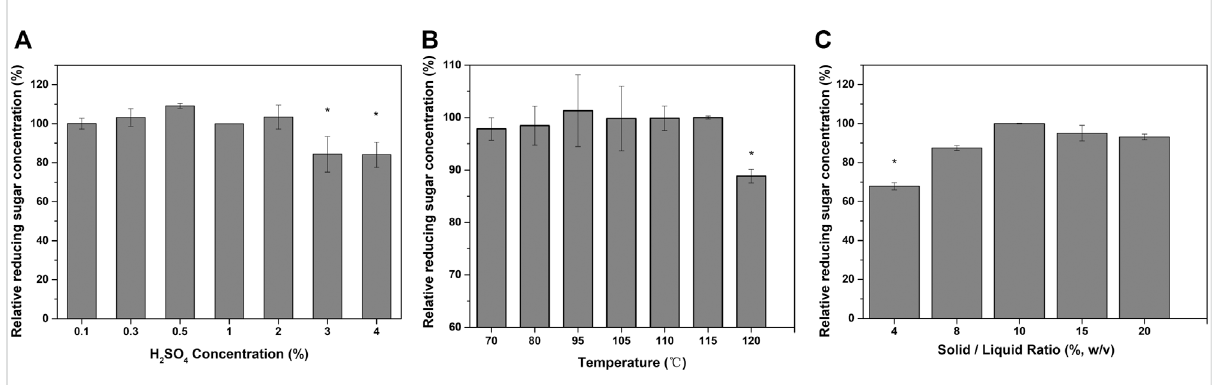
FIGURE 2 Effects of different acid pretreatment conditions on the enzymatic hydrolysis of TSW: (A) sulfuric acid concentration; (B) pretreatment temperature; and (C) solid-to-liquid